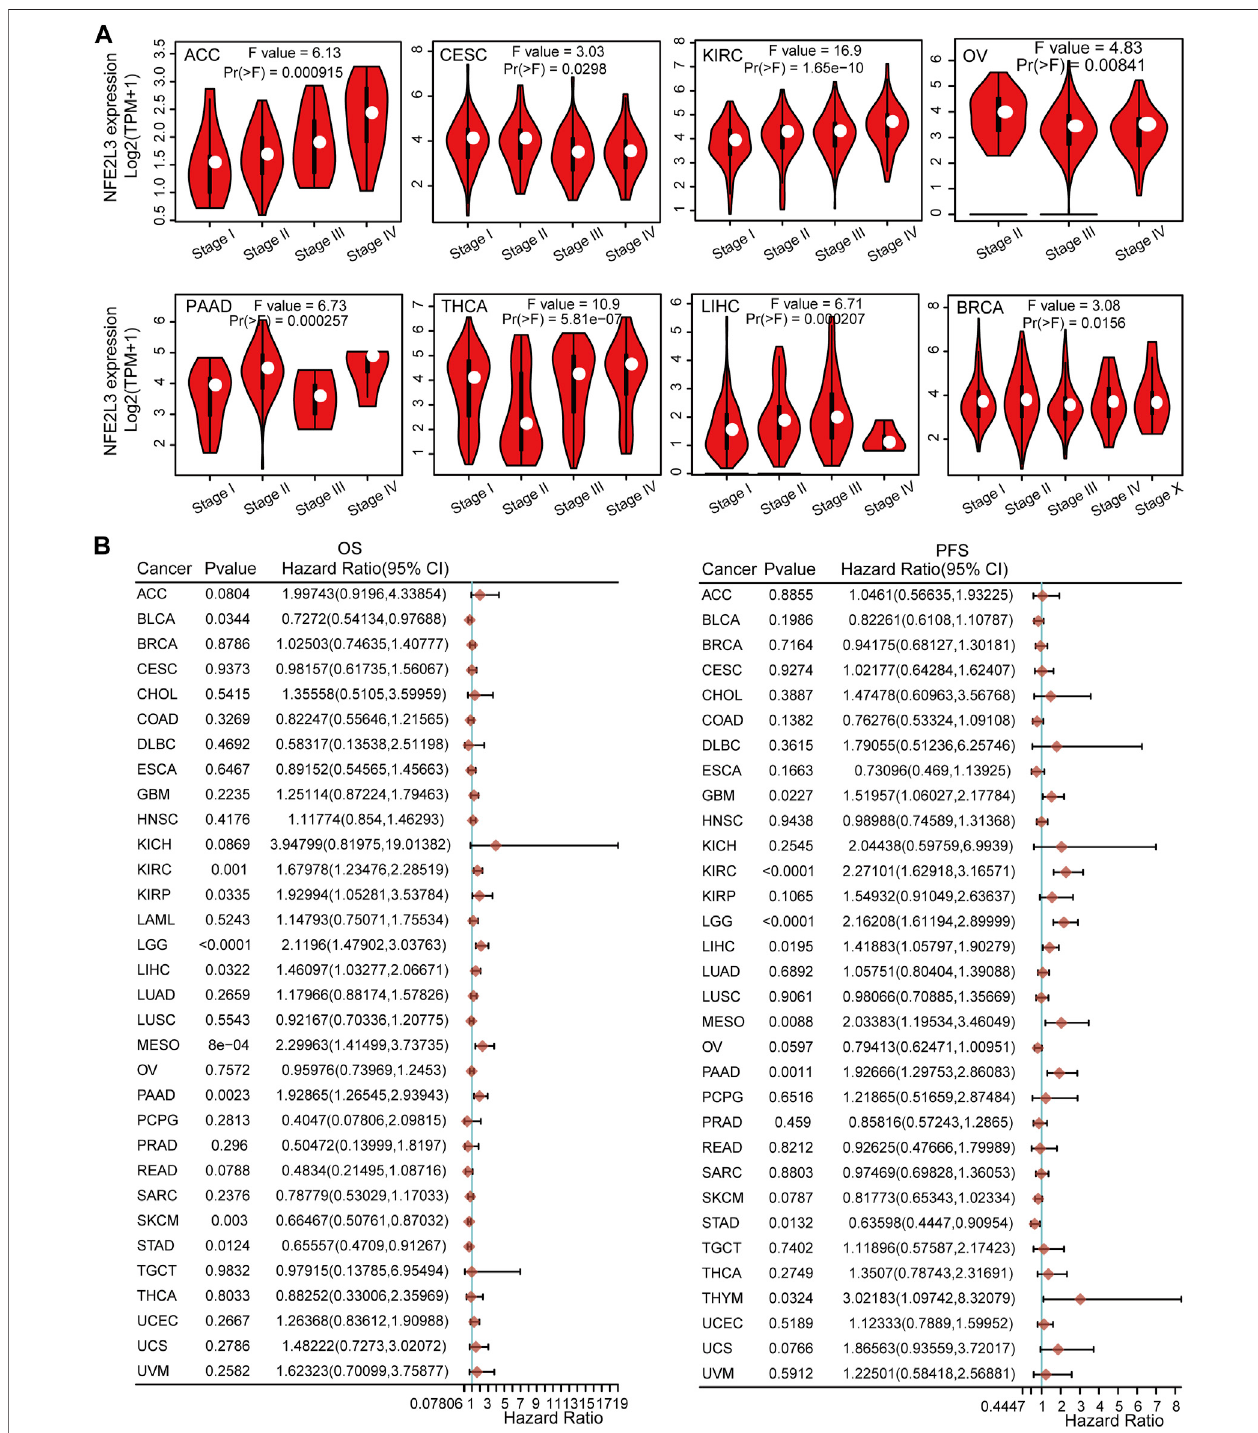
FIGURE 3 | The relationship between NFE2L3 expression and prognosis and pathological stages in different tumors. (A) The association between NFE2L3 expression and thepathological stage was analyzed in ACC,CESC, KIRC, OV, PAAD, THCA, LIHC, and BRCAby the GEPIA2 database. (B) The correlation ofNFE2L3 expression and Overall survival (OS) and progression-free survival (PFS) prognosis in pan-cancer.